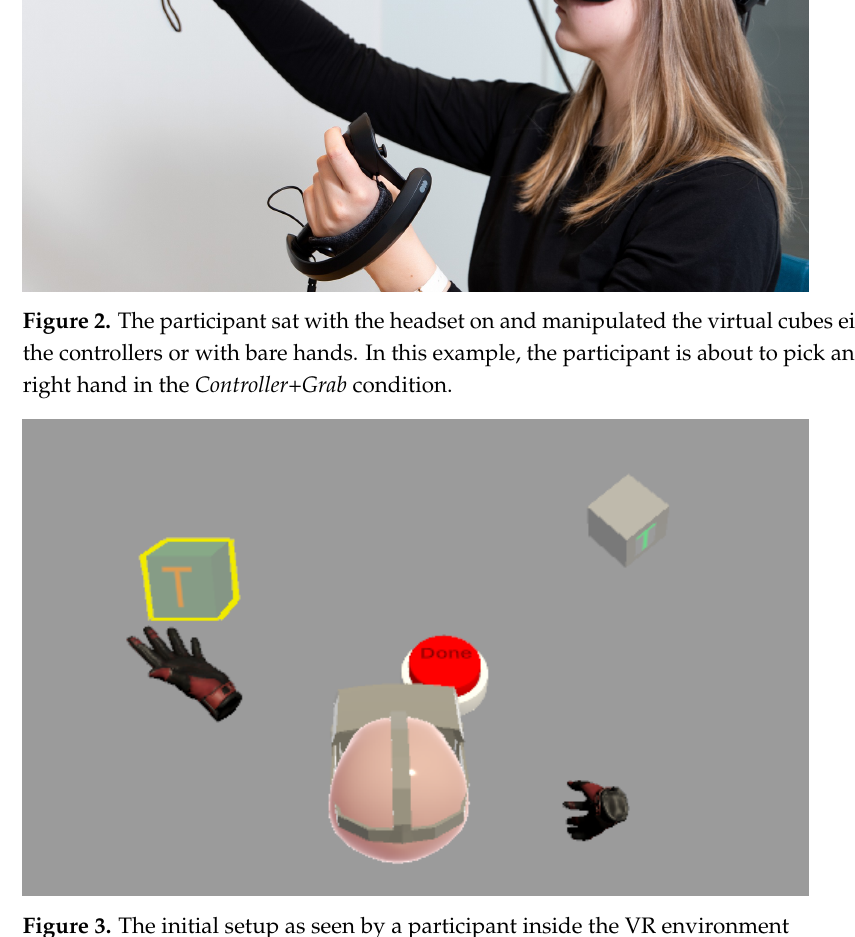
Figure 3. The initial setup as seen by a participant inside the VR